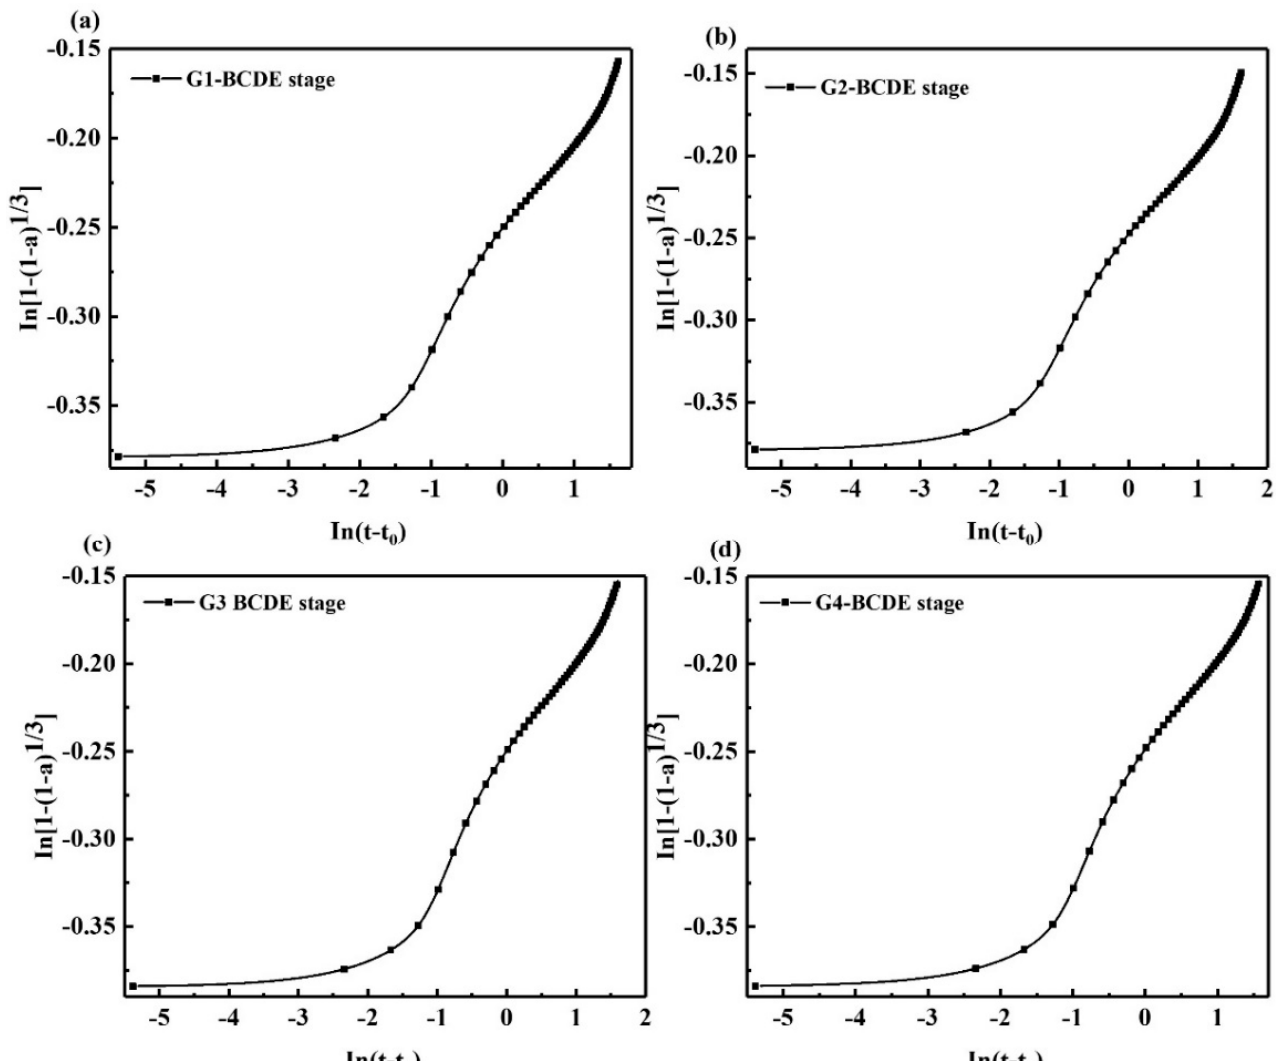
Figure 5. ln [1-(1- α ) 1/3 ]-ln(t-t 0 ) curve of SAC in hydration acceleration stage (BCDE stage); ( a ) G1, Figure 5. ln [1 − (1 − α ) 1/3 ] − ln(t − t 0 ) curve of SAC in hydration acceleration stage (BCDE stage); ( b ) G2, ( c ) G3, ( d ) G4. ( a ) G1, ( b ) G2, ( c ) G3, ( d ) Table 5. Results of Kondo equation piecewise fitting hydration acceleration initial stage.